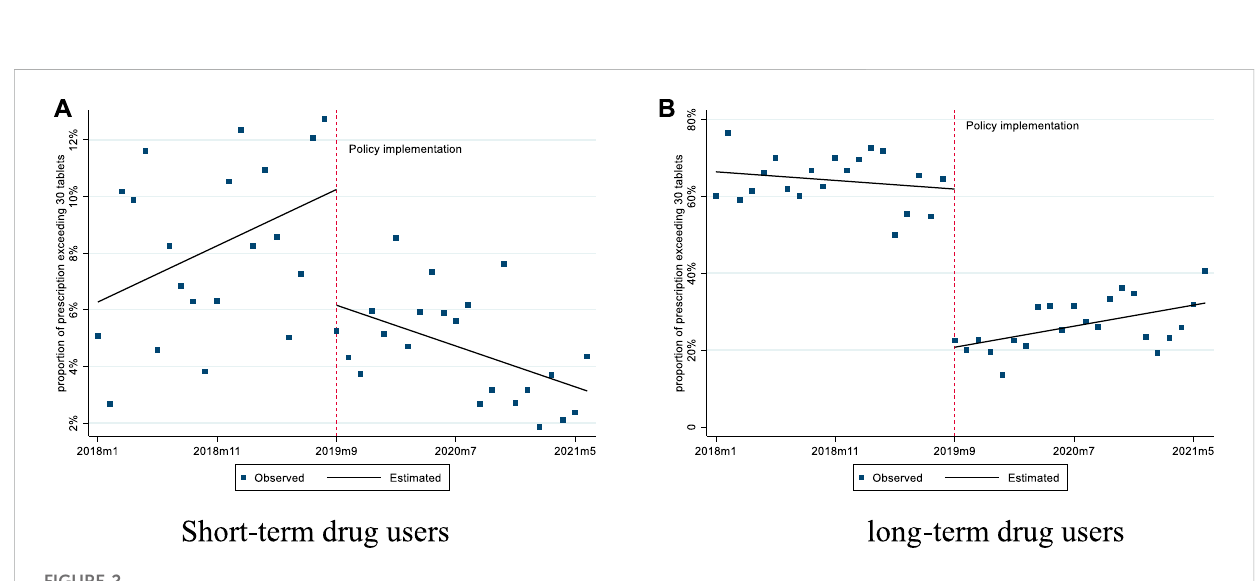
FIGURE 2 Changesintheproportion ofprescriptionexceeding 30pills forshort-termandlong-term drug users. (A) Short-termdrugusers (B) long-term drug